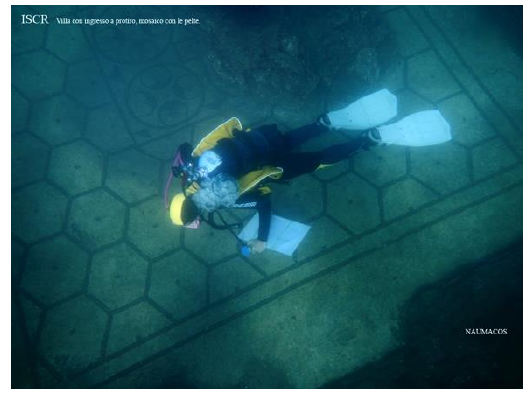
Fig. 2 – Villa con ingresso a Protiro, the black and white mosaic decorated with hexagons and peltae. (ISCR Archive) This mosaic lies inside a rectangular room measuring 4.77 metres by 5.55. The mosaic consists of a background of white tesserae with ornamental motifs created using a double line of black tesserae. The principal motif is a series of hexagons covering the whole floor, with a square of four black tesserae at the centre of each hexagon. Black tesserae also make up the double border around the edges. The central section is a pseudo- emblema consisting of four circles enclosed by a large square, with four peltae inside each circle. Three equidistant solid black equilateral triangles lie between the circles inside each side of the square. There is a quincunx (the five-spot motif on six-sided dice) at the centre of each circle. The point of each pelta terminates in a small flower with three heart-shaped petals separated by a central dot. The remaining space between the four circles contains a small square enclosing a cruciform floral motif with a central dot. The floral motif has lobed petals with arrowhead tips. The mosaic dates back to the second century BC. Together with this mosaic, the 3D documentation involved also a very fragmentary black and white mosaic (Fig. 3 A) and a stone artefact probably a threshold of a sliding door (Fig. 3 B).